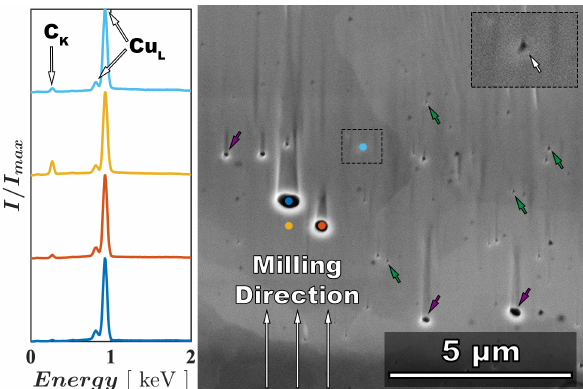
Figure 3. Secondary electron micrograph of the defects in the ion milled trench. The locations of EDS point scans are shown in solid colored circles; the corresponding spectra are shown in the plot to the left. The pores are identified with colored arrows; green, upward pointing arrows denote defects with apparent three-fold symmetry. Purple, downward pointing arrows identify spherical defects.